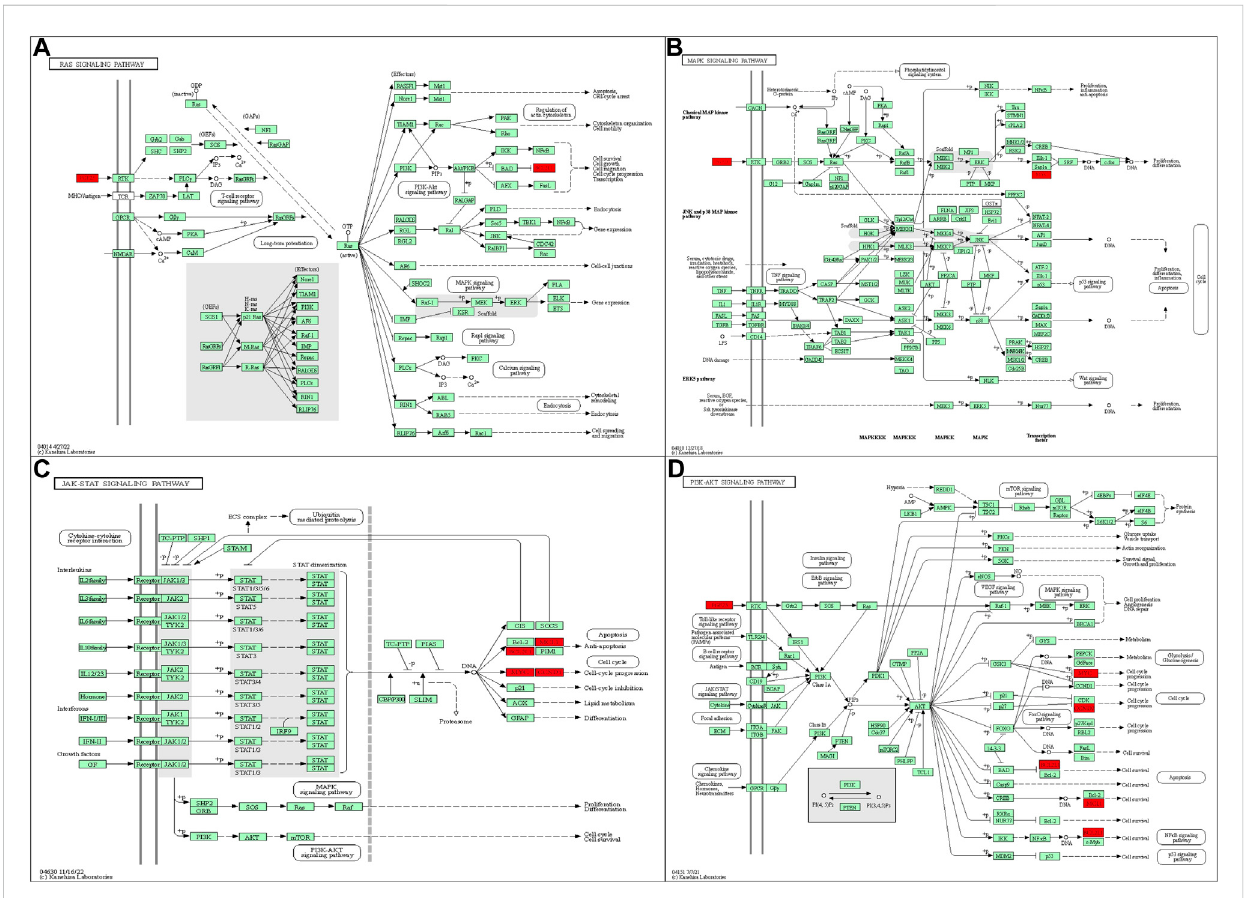
FIGURE 5 (A) FGF23 and BCL2L1 in the RAS signaling pathway. (B) FGF23 and MYC in the MAPK signaling pathway. (C) MCL1, BCL2L1, MYC, and CCND2 in the JAK-STAT signaling pathway. (D) CCND2, FGF23, MCL1, MYC, and BCL2L1 in the PI3K-AKT signaling pathway. All fi gures are included from the KEGG